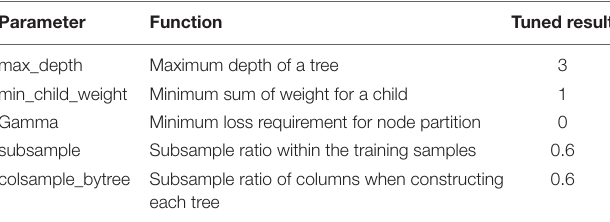
TABLE 3 | Parameters tuned for XGBoost under multi-label